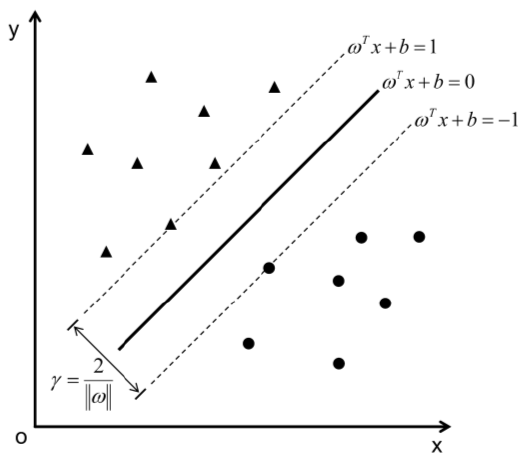
Figure 3. Schematic diagram of SVM.